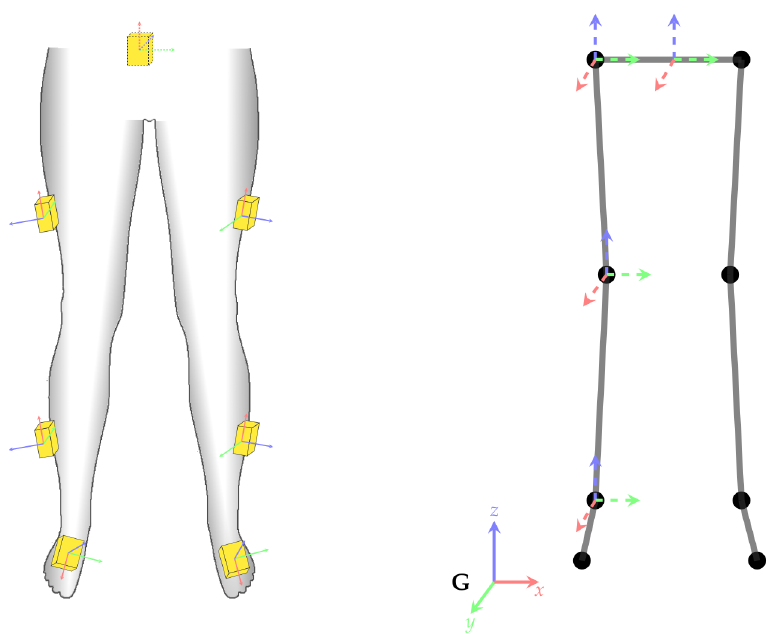
Figure 8. ( Left ) IMU configurations used for the recording of dataset C (dashed lines mark IMUs placed on the back); and ( Right ) skeleton with exemplary segment coordinate systems of pelvis and right leg (analogous for left leg). The global coordinate system ( G ) is a fixed reference coordinate